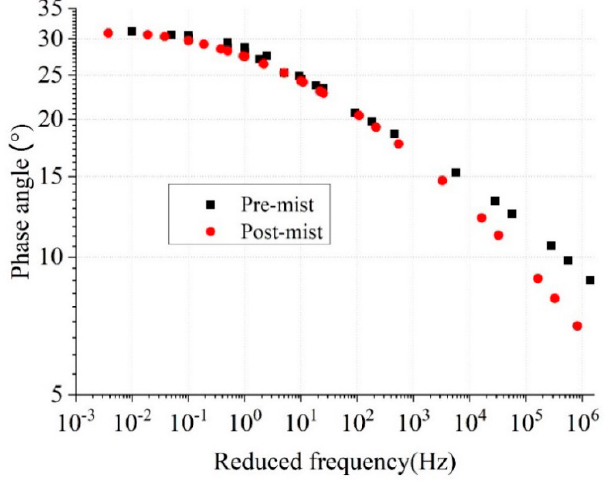
Figure 8. Master curve of phase angle at 21 °C of pre-mist and post-mist CIR asphalt mixture. The rutting index of the pre-mist and post-mist CIR mixtures at the loading frequency of 10Hz is displayed in Figure 9. The rutting parameter (|E*|/sin δ ) quantifies the rutting property of the asphalt mixture. The MIST process reduced the rutting parameter of the mixture. For example, the rutting parameter of the asphalt mixture decreased by 13% at − 10 °C and by 41% at 37 °C. This reduction effect was significant at high temperatures, which was very important because at high temperatures rutting was easier to accumulate on the pavement. The stiffness of the asphalt mixture decreased after fiber modification, thus weakening the rutting resistance of the asphalt mixture. It should be mentioned that the high value of error bar at − 10 °C may be caused by moisture frozen in the mixture.